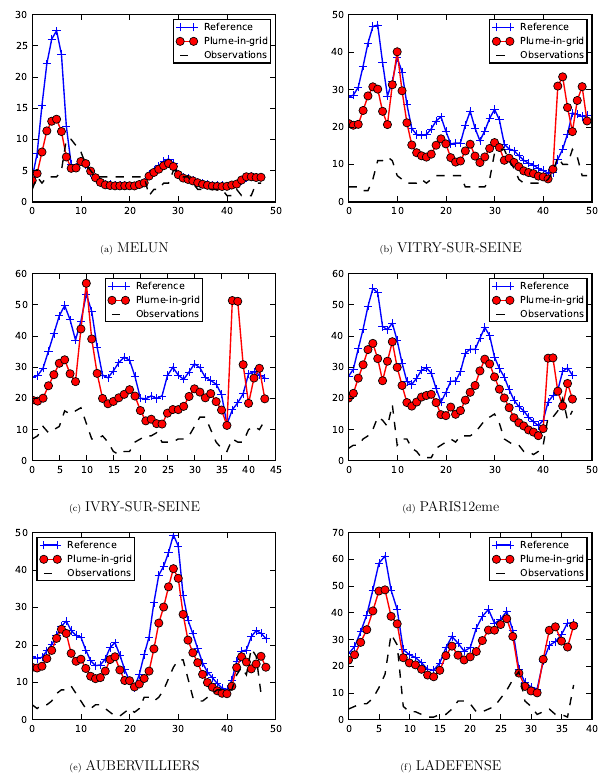
Fig. 9. SO 2 profiles during two days, from 2001-08-23 at 03:00 (local time) to 2001-08-25 at the same hour, at six stations. Profiles are shown for the measurement, reference simulation and plume-in- grid simulation with similarity